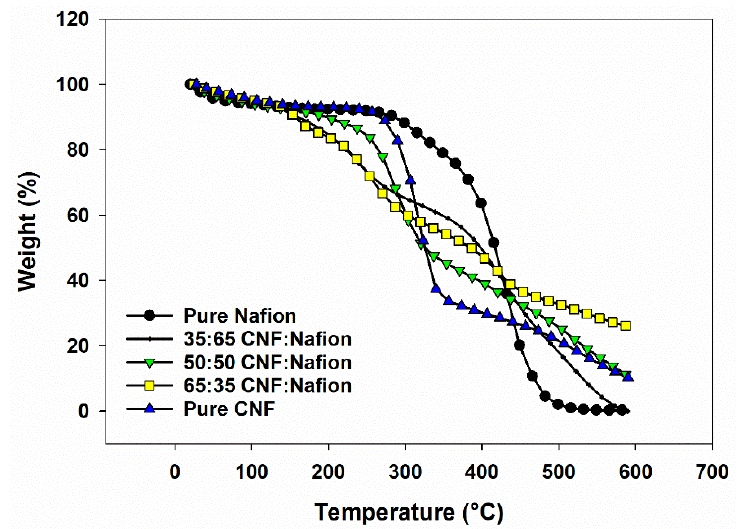
Figure 4. TG graph of membranes of Nafion ® , CNF and hybrids of Nafion-CNF with different ratios in nitrogen atmosphere.